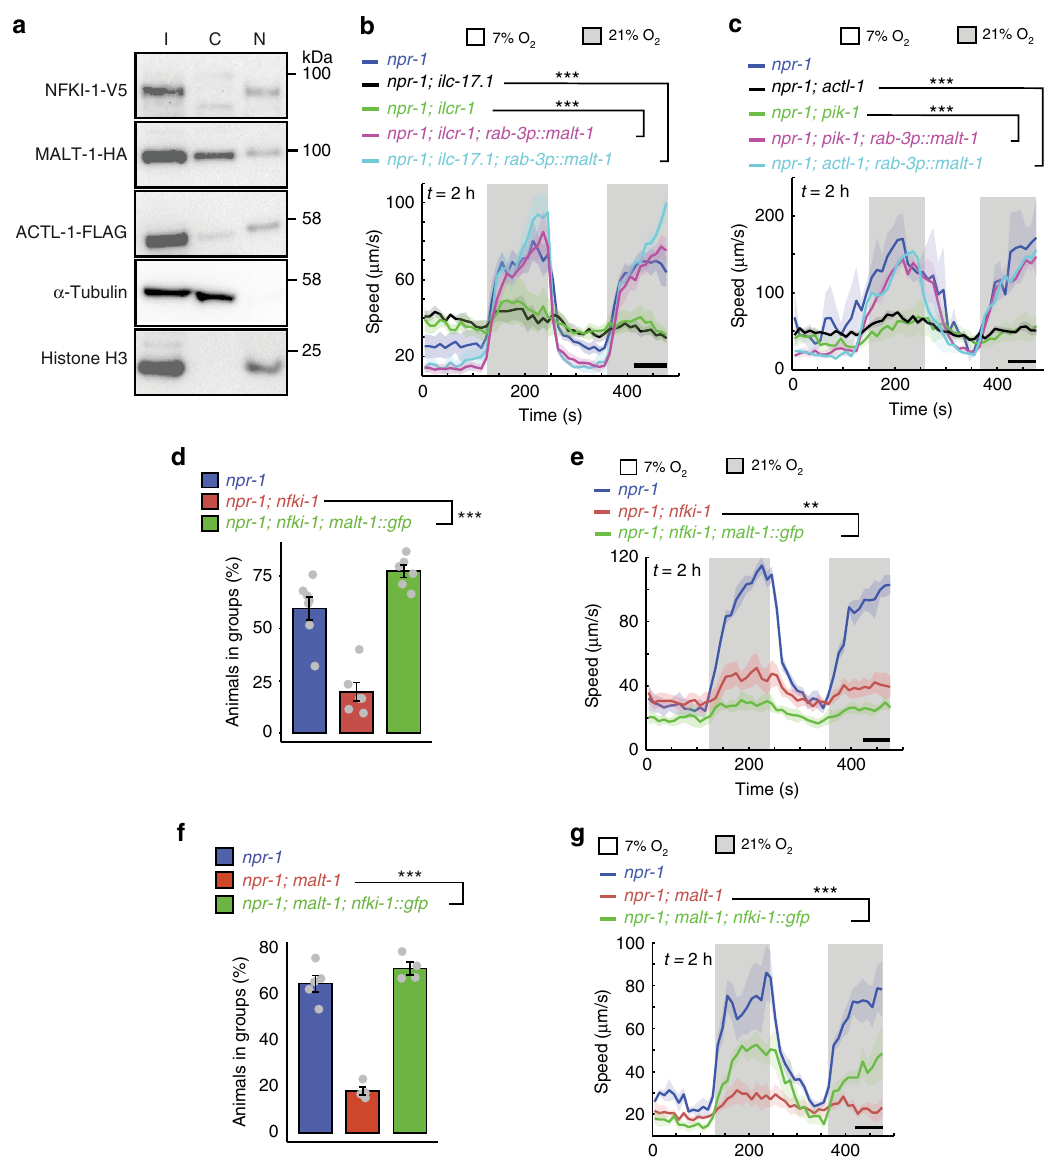
Fig. 7 MALT-1 and NFKI-1 provide partially parallel outputs of IL-17 signaling. a Immunoblot analysis of IL-17 signaling components from nuclear and cytoplasmic fractions of C. elegans lysate. I, input, C, cytosolic, N, nuclear. NFKI-1 is predominately nuclear; ACTL-1 and MALT-1 are distributed between the nucleus and cytoplasm. Similar results were obtained in 5 experiments. b and c Overexpressing malt-1 in neurons, using the rab-3 promoter, restores the arousal response to 21% O 2 to ilc-17.1 and ilcr-1 mutants ( b ), and actl-1 and pik-1 mutants ( c ). b n = 52 animals ( npr-1 ), n = 104 animals ( npr-1; ilcr-1 ), n = 71 animals ( npr-1; ilcr-1; rab-3p::malt-1 ), n = 86 animals ( npr-1; ilc-17.1 ), n = 61 animals ( npr-1; ilc-17.1; rab-3p::malt-1 ). c n = 19 animals ( npr-1 ), n = 46 animals ( npr-1; actl-1 ), n = 26 animals ( npr-1; actl-1; rab-3p::malt-1 ), n = 33 animals ( npr-1; pik-1 ), n = 28 animals ( npr-1; pik-1; rab-3p::malt-1 ). Plots show average speed (line) and SEM (shaded regions). *** P < 0.001, two-sided Mann-Whitney U test. d and e Overexpressing malt-1 gDNA also rescues the aggregation phenotype ( d ), but not the arousal defect ( e ) of nfki-1 mutants. d N = 7 assays ( npr-1 ), N = 6 assays ( npr-1; nfki-1 and npr-1; nfki-1; malt-1::gfp ). *** P = 3.5e − 05, one-way ANOVA with Tukey ’ s post hoc HSD. e n = 47 animals ( npr-1 ), n = 79 animals ( npr-1; nfki-1 ), n = 39 animals ( npr-1; nfki-1; malt-1::gfp ). ** P = 0.0067, two-sided Mann-Whitney U test. f and g The aggregation phenotype of malt-1 is rescued by overexpressing nfki-1 cDNA ( f ), while speed defects are partially rescued ( g ). f N = 5 assays ( npr-1 ), N = 4 assays ( npr-1; malt-1 and npr-1; malt-1; nfki-1::gfp ). *** P = 7e − 07, one-way ANOVA with Tukey ’ s post hoc HSD. g n = 36 animals ( npr-1 ), n = 50 animals ( npr-1; malt-1 ), n = 44 animals ( npr-1; malt-1; nfki-1::gfp ). *** P = 7e − 07, one-way ANOVA with Tukey ’